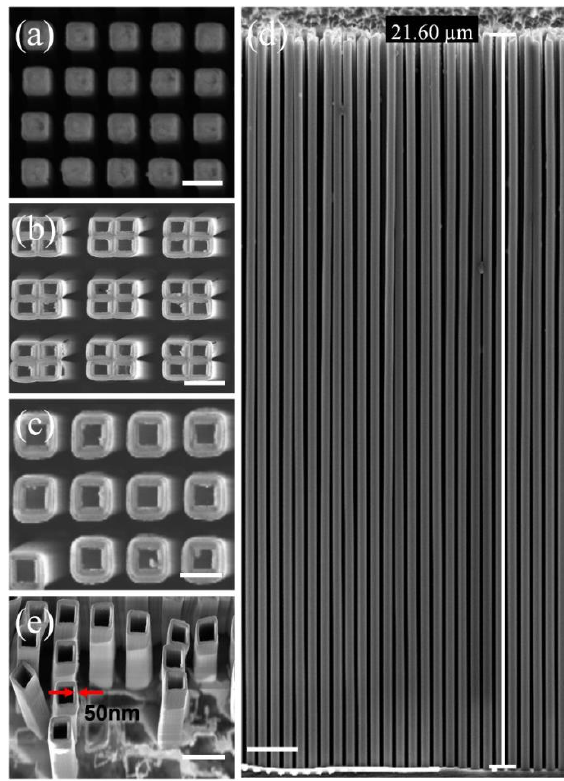
Figure 5. A series of images demonstrating sidewall transfer MacEtch for the preparation of ultra-high aspect ratio Al 2 O 3 nanotube arrays. ( a ) Top view SEM of the Si nanostructures after Al 2 O 3 film deposition by ALD. The scale bar is 300 nm. ( b ) Top view SEM of the generated Al 2 O 3 nanotube arrays without annealing process. The scale bar is 400 nm. ( c , d ) SEM images of the top and cross section views of the generated Al 2 O 3 nanotube arrays resulting from the sidewall transfer MacEtch process. The scale barsin ( c , d ) are 250 nm and 1.6 µ m, respectively. ( e ) Tilted SEM view of Al 2 O 3 nano-tube structures after the whole process. The scale bar is 400 nm. The tilting angle is 35°.